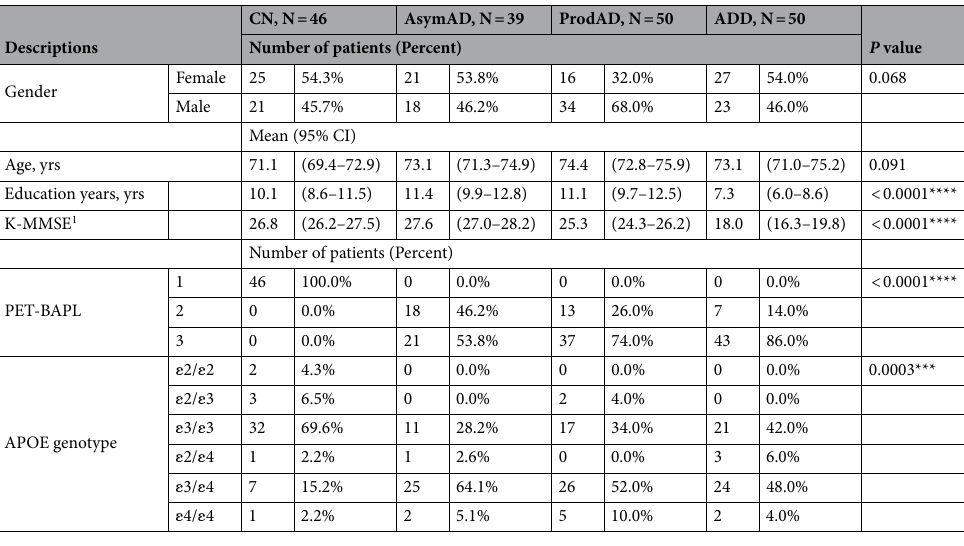
Table 1. Demographics of the three Alzheimer disease groups. 1 Higher score represents better cognitive function; Significance level is represented as “***” for P < 0.001 and “****” for P < 0.0001; Cognitive normal, CN; Asymptomatic Alzheimer disease, AsymAD; Prodromal Alzheimer disease, ProdAD; Alzheimer disease dementia, ADD.